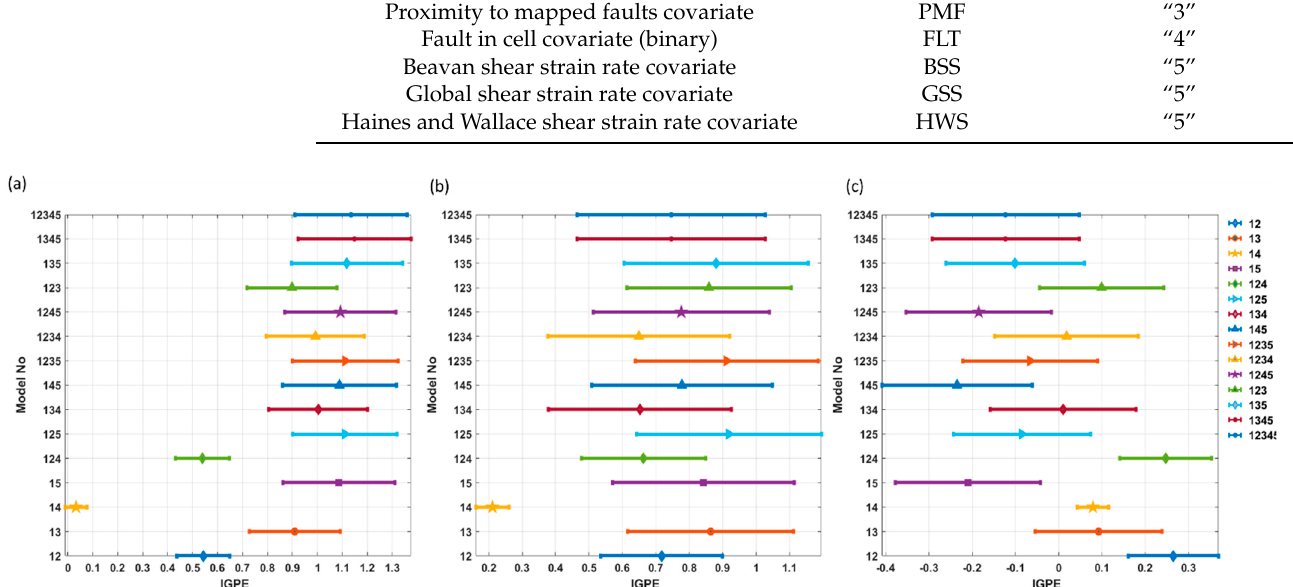
Figure 3. Information gain per earthquake (IGPE) of hybrid models relative to SUP baseline model with the Beavan shear strain rate (BSS) covariate. The combination of covariates contributing to each hybrid is indicated by the model number, which is a composite of the numbers corresponding to the baseline model and selected covariates, as follows: 1-SUP; 2-PPI; 3-PMF; 4-FLT; 5-BSS. ( a ) Fitting period (1987–2006); ( b ) Forward testing period (2012–2015); ( c ) Reverse testing period (1951–1986). Error bars are 95% confidence intervals.